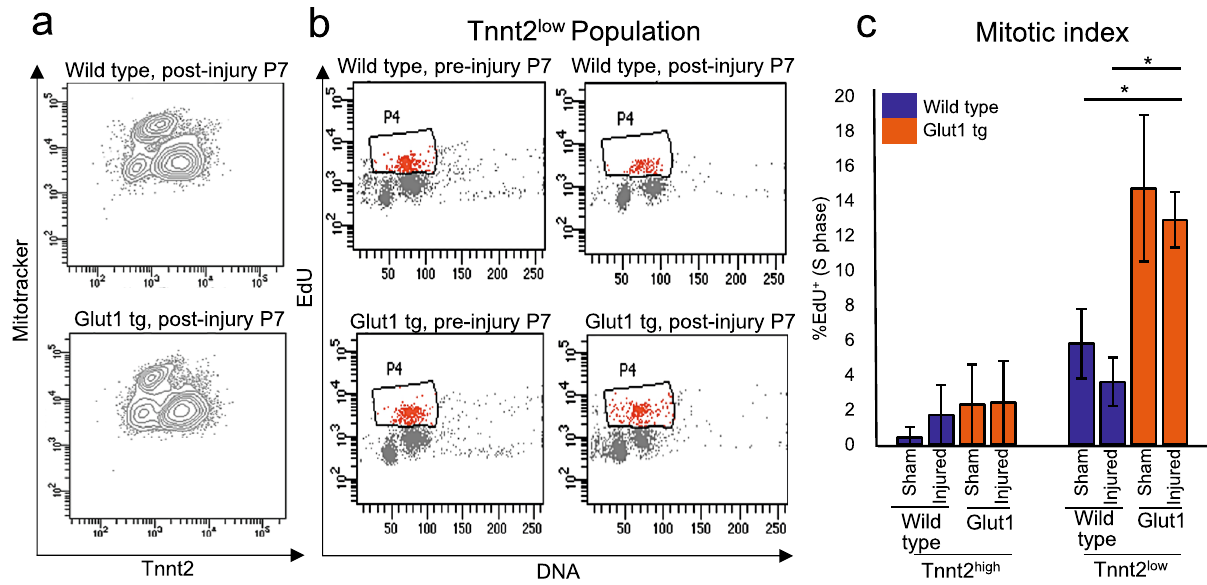
Figure 3. Tnnt2 low cardiomyocytes are mitotically activated by the increase in intracellular glucose. ( a ) Representative flow cytometry profile of the ventricular cardiomyocytes from P7 Wild type and Glut1 transgenic hearts stained with Tnnt2 and Mitotracker. ( b ) Representative flow cytometry plot of EdU incorporation assay of Tnnt2 low cardiomyocytes. Wild type and Glut1 transgenic mice were injected with EdU and the ventricular cardiomyocytes were isolated and analyzed by Tnnt2, Mitotracker, and EdU staining. ( c ) Mitotic index of Tnnt2 high and Tnnt2 low cardiomyocytes in Wild type and Glut1 transgenic heart with or without injury. n = 3–8. * p < 0.05. *** p < 0.001. Note that Tnn2 low cardiomyocytes are more mitotic than Tnn2 high cardiomyocytes